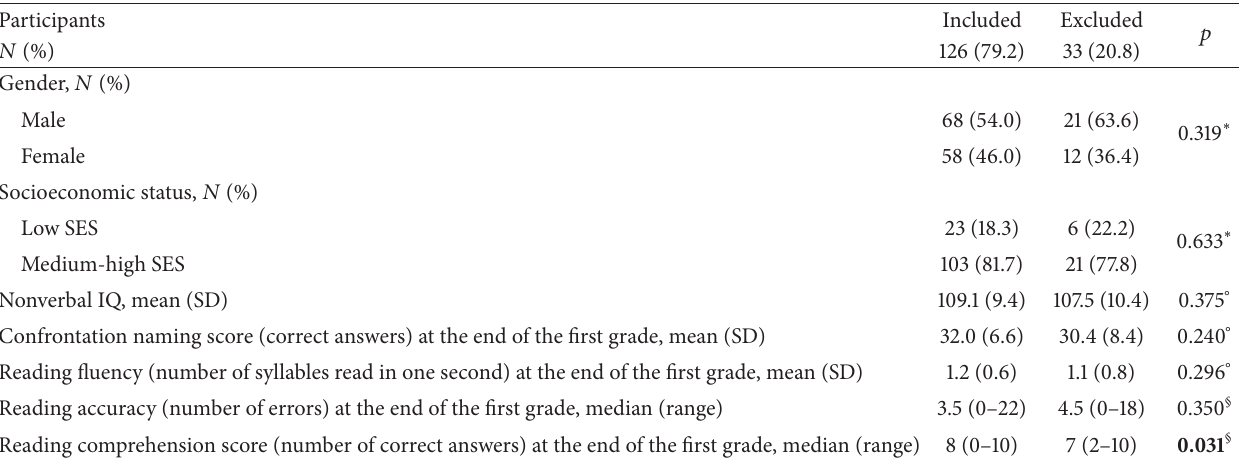
Table 1: Demographic characteristics of participants included in the analysis and those excluded because they did not complete the follow- up. Comparisons were made by chi-square ( ∗ ), independent samples 𝑡 -test ( ∘ ), and Mann-Whitney 𝑈 test (§). Reported data are number of patients with percentages shown in brackets, unless specified